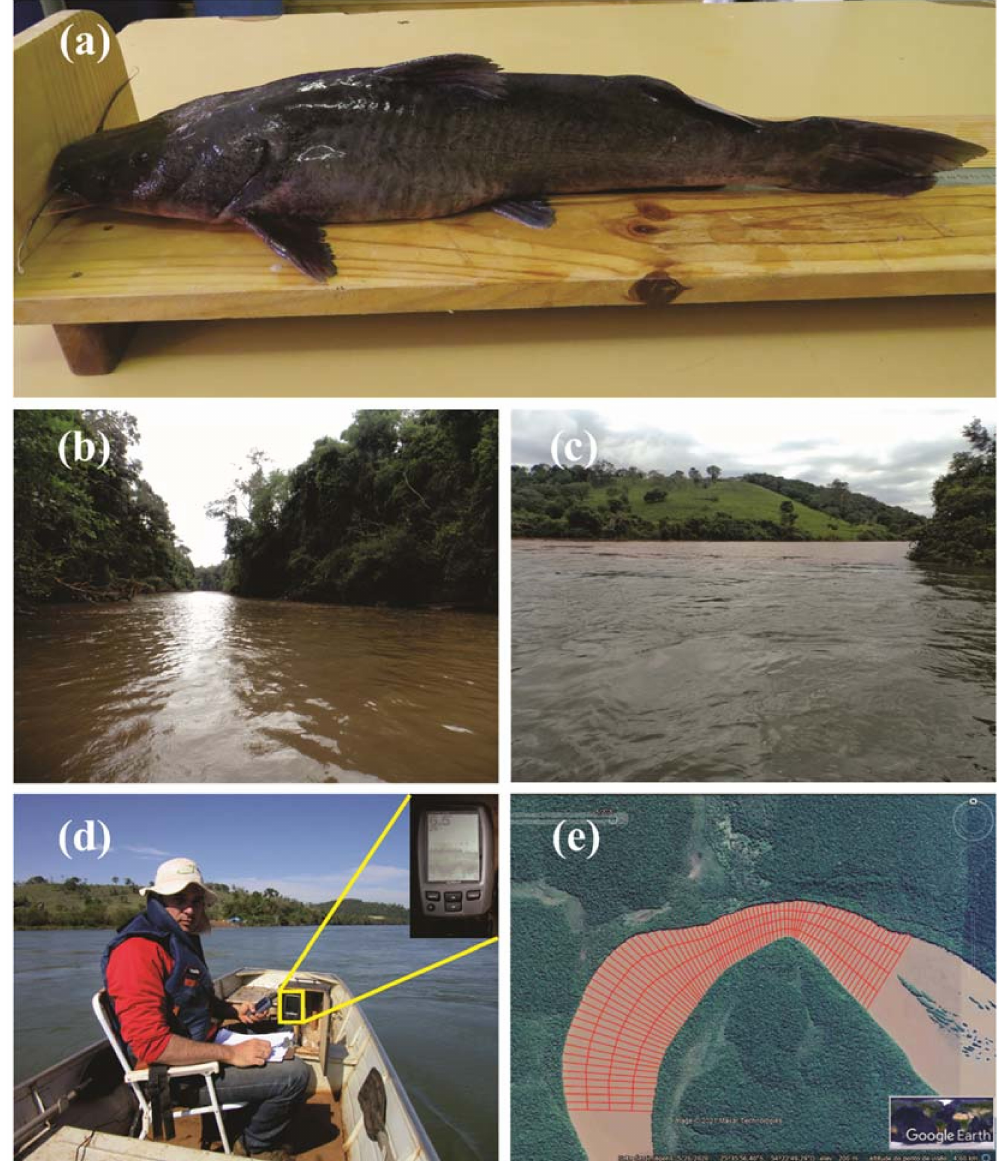
Figure 2. Specimen of Steindachneridion melanodermatum captured in the study area ( a ); sampling sites in the protected area at site 22 in Silva Jardim River ( b ) and outside of the protected area at site 8 in Iguaçu River ( c ); deep pools mapping ( d , e